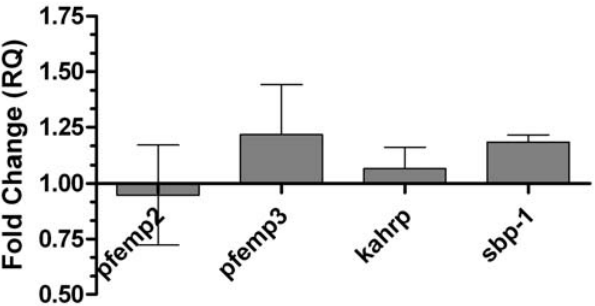
Figure 2. Analysis of expression of exported non- var genes upon exposure to 10 m M tBHP in NF-54 parasites. Stress induction, cDNA production and qPCR analysis were performed as described in the legend to Fig. 1. Error bars represent mean of triplicates 6